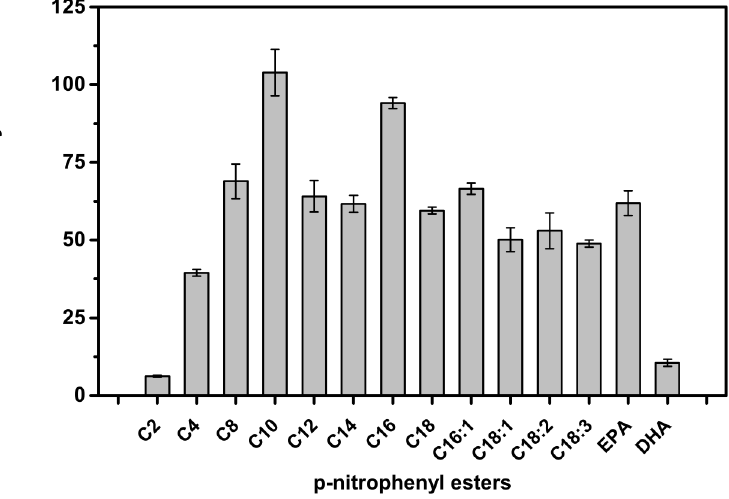
Fig 1. Phospholipase A1 activity towards p NP esters with different acyl chains. Activity of PLA1 on pNP-decanoate was taken as 100%.